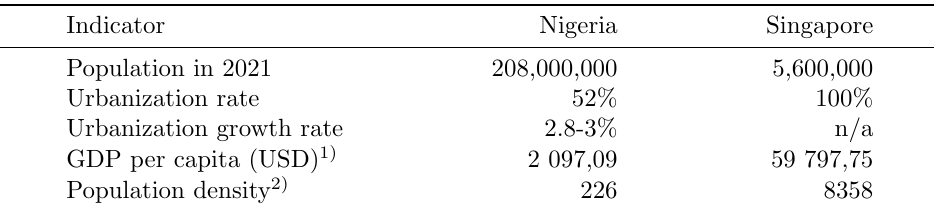
Table 1: Selected socio-economic indicators